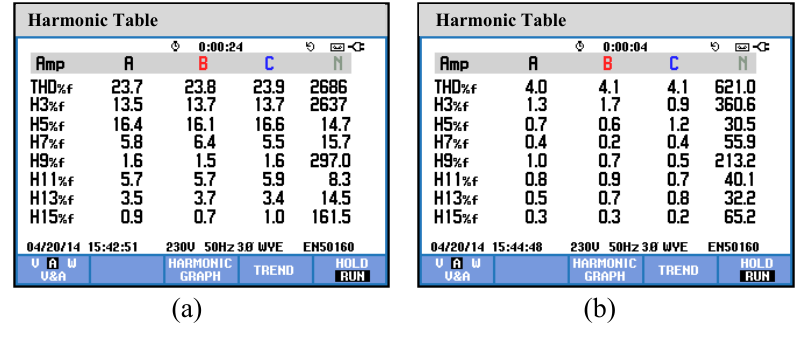
Figure 18. Harmonic forms of the ( a ) load current and ( b ) grid